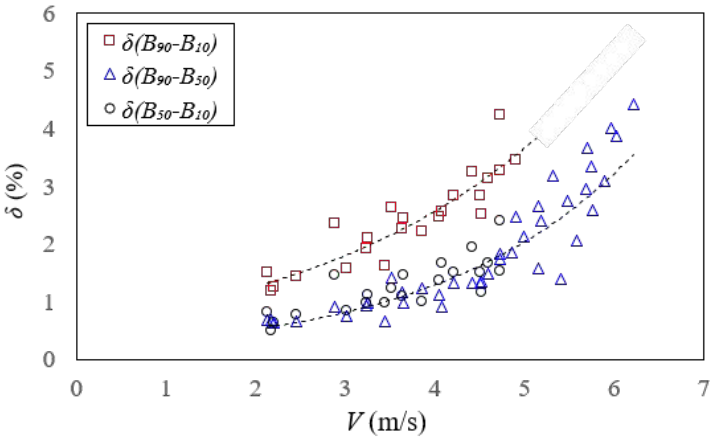
Figure 8. Lateral expansion angles as a function of the jet velocity.